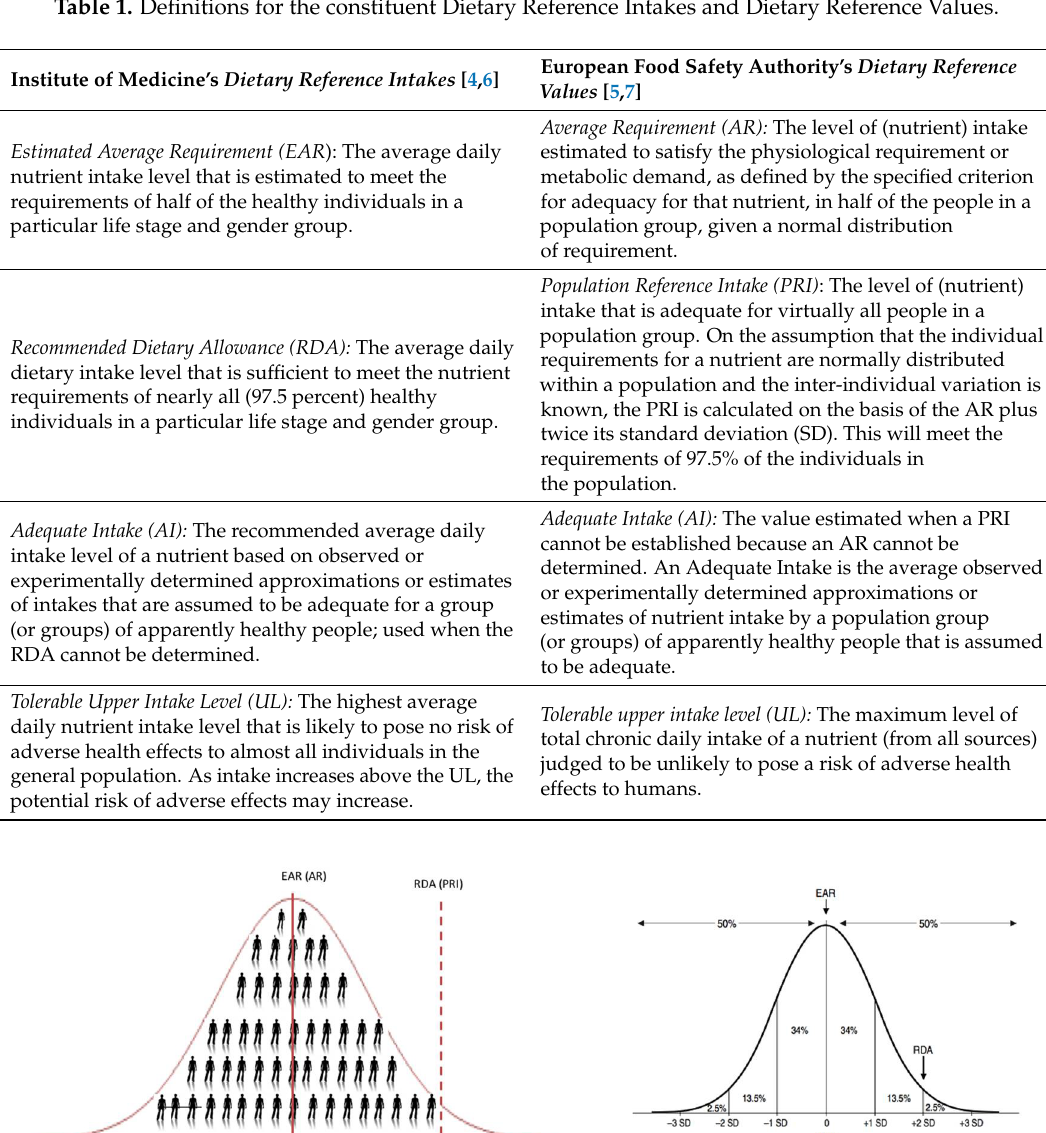
Table 1. Definitions for the constituent Dietary Reference Intakes and Dietary Reference Values.